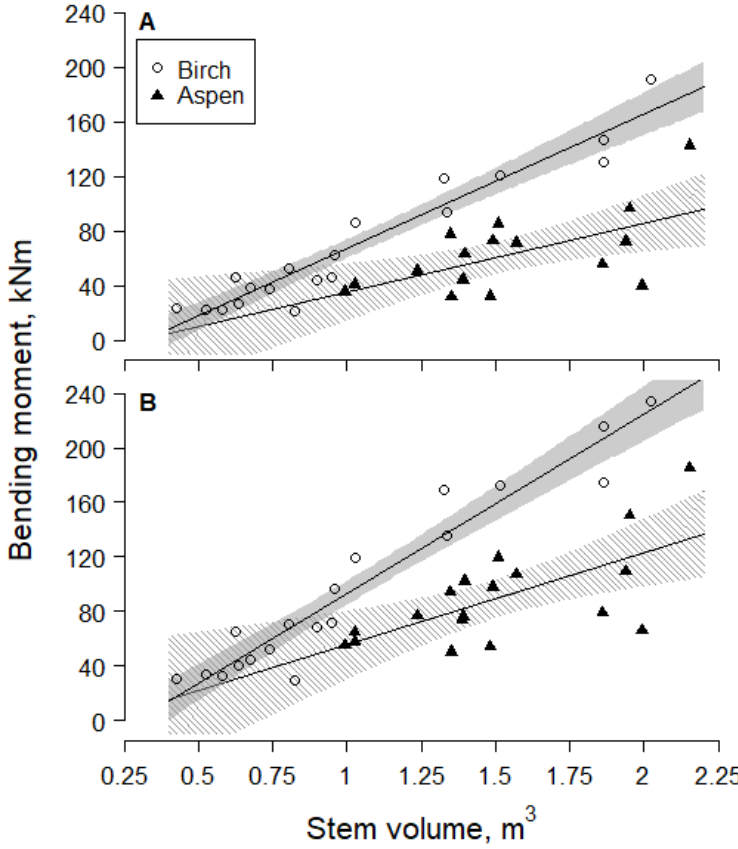
Figure 1. Basal bending moment of common aspen and silver birch stems at the ( A ) primary failure (BBM PF ) and the ( B ) secondary failure (BBM SF ) The coloured area indicates 95% confidence interval.